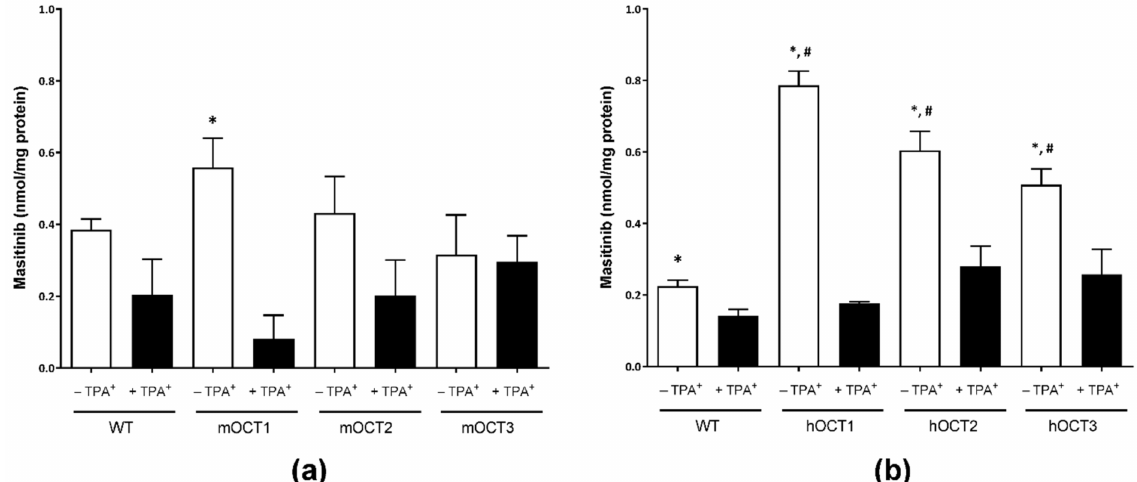
Figure 3. Columns indicate Masitinib accumulation in WT- ( n = 12) and m (panel ( a )) or h (panel ( b )) OCT1-3 stably expressing HEK293 cells in the presence (+ TPA + ) or absence ( − TPA + ) of 1 mM of TPA + . Columns show the mean ± SEM of Masitinib uptake given as nmol Masitinib/mg protein measured in 9–12 replicates in 3 independent experiments. In panel a, * shows a statistically significant difference to experiments performed with mOCT1-expressing cells in the presence of 1 mM of TPA + (unpaired t -test). In panel b, * shows a statistically significant difference to respective experiments performed in the presence of 1 mM of TPA + (unpaired t -test), while # shows a statistically significant difference to WT without TPA + (ANOVA with Tukey